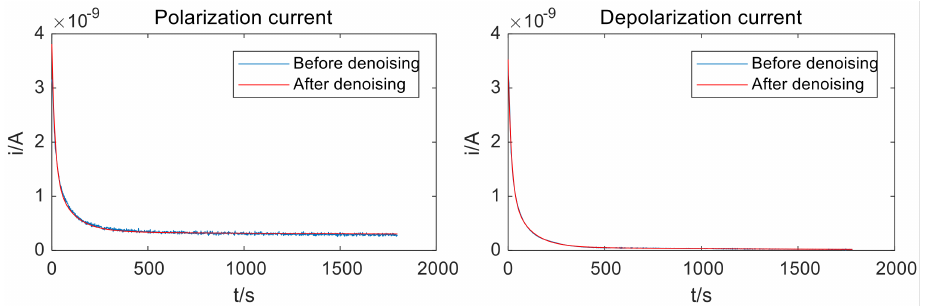
Figure 9. The fitting situation of original curve and denoised curve. Table 1. Calculation results of R new of an oil-film dielectric under different aging states. Times of Impulse